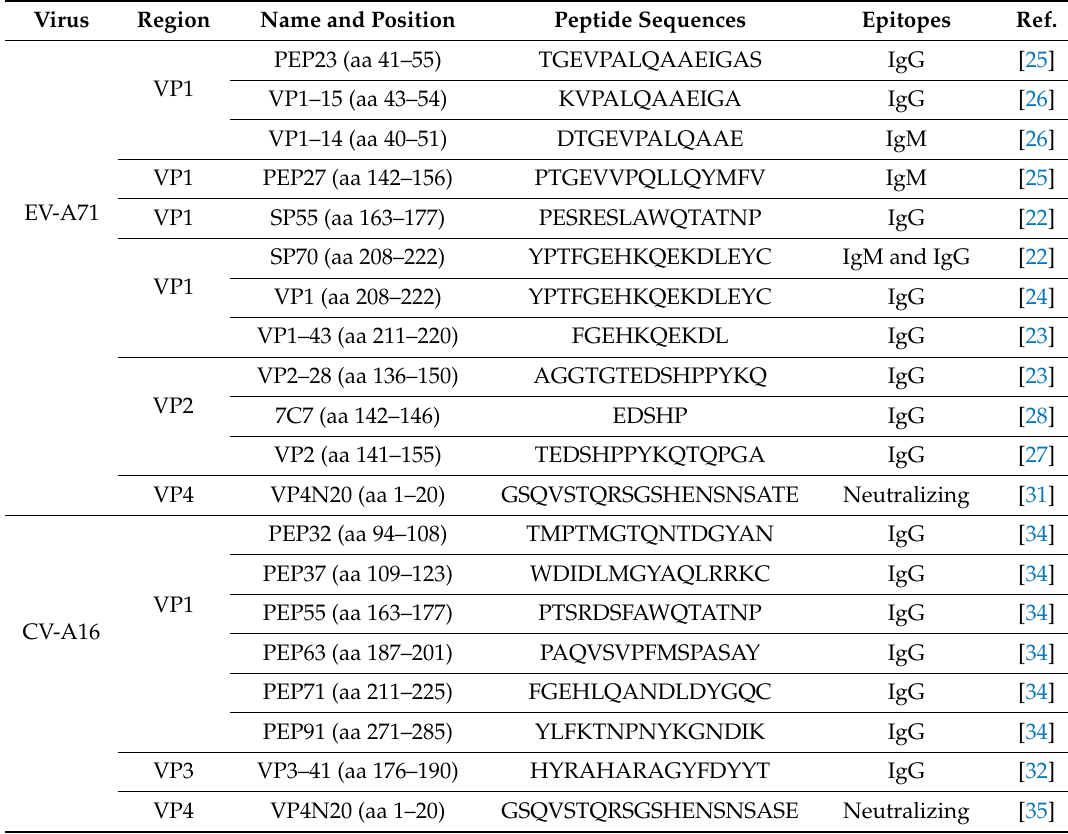
Table 1. Experimentally mapped linear epitopes in the structural proteins of EV-A71 and CV-A16. Virus Region Name and Position Peptide Sequences Epitopes